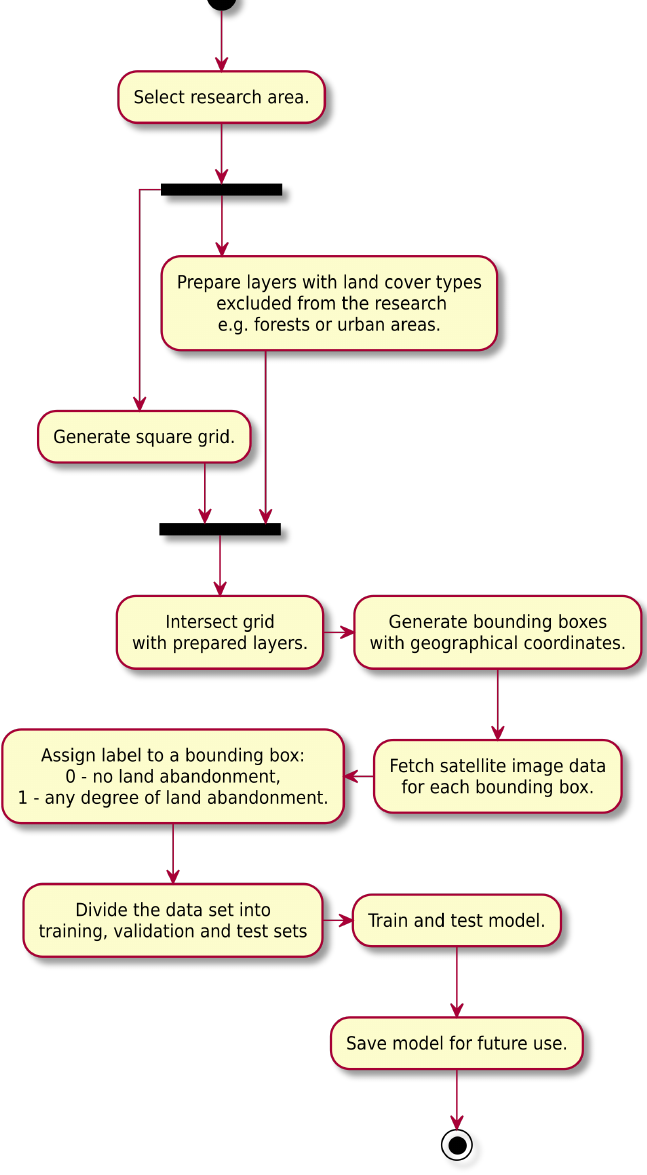
Figure 2. Model training